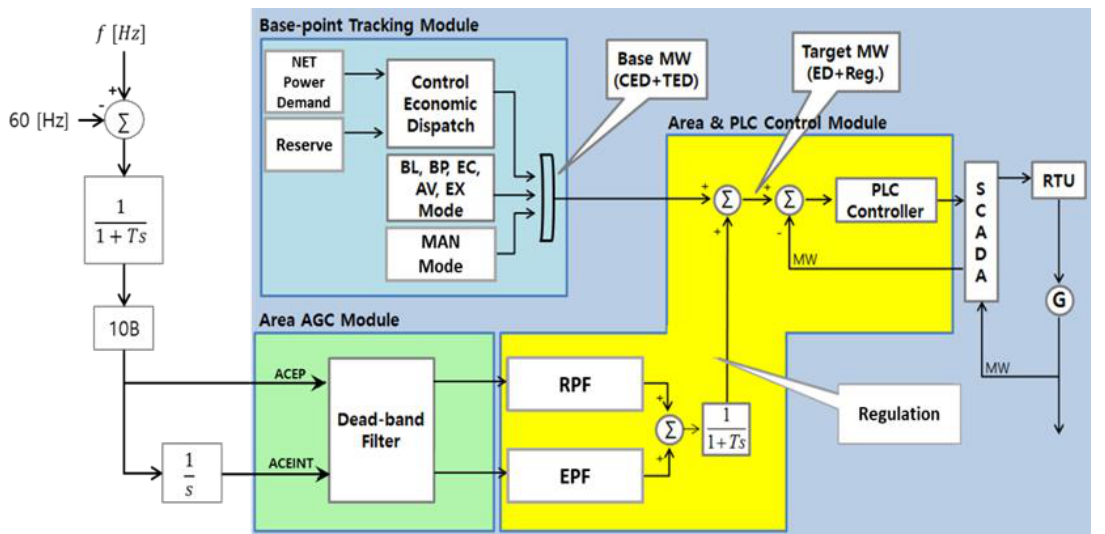
Figure 1. Automatic generation control (AGC) operation in the Korean power system.